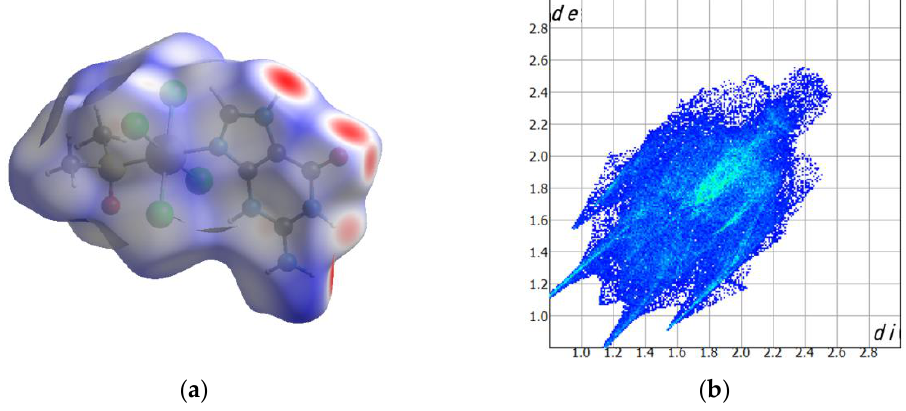
Figure 4. ( a ) Hirshfeld surface of 1 calculated through d norm function; ( b ) Fingerprint maps for compound 1 (see text).